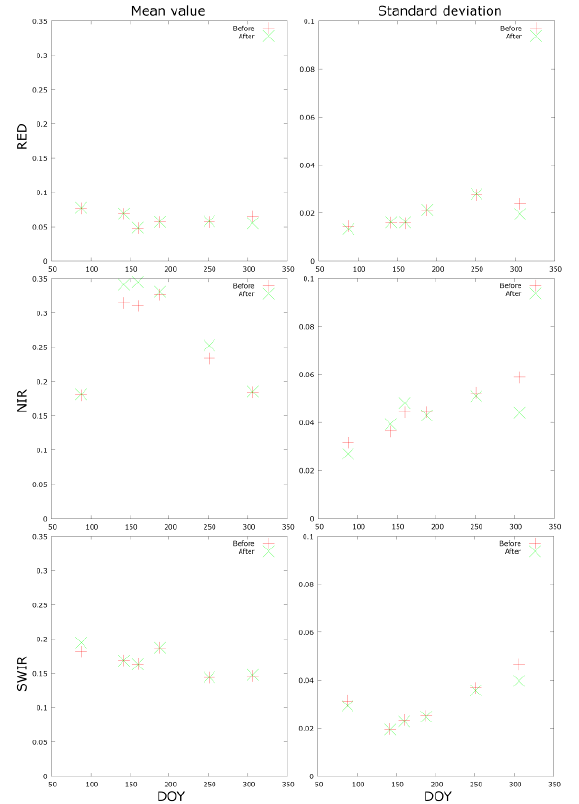
Figure 5. Example of mean and standard deviation plots for PROBA-V bands and broad-leaf forest land cover class before and after topographic